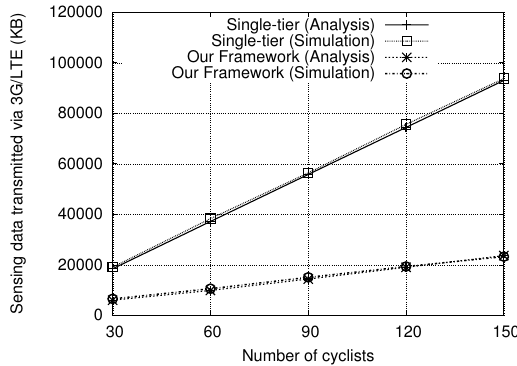
Figure 3. Comparisons of simulation and analytical results.